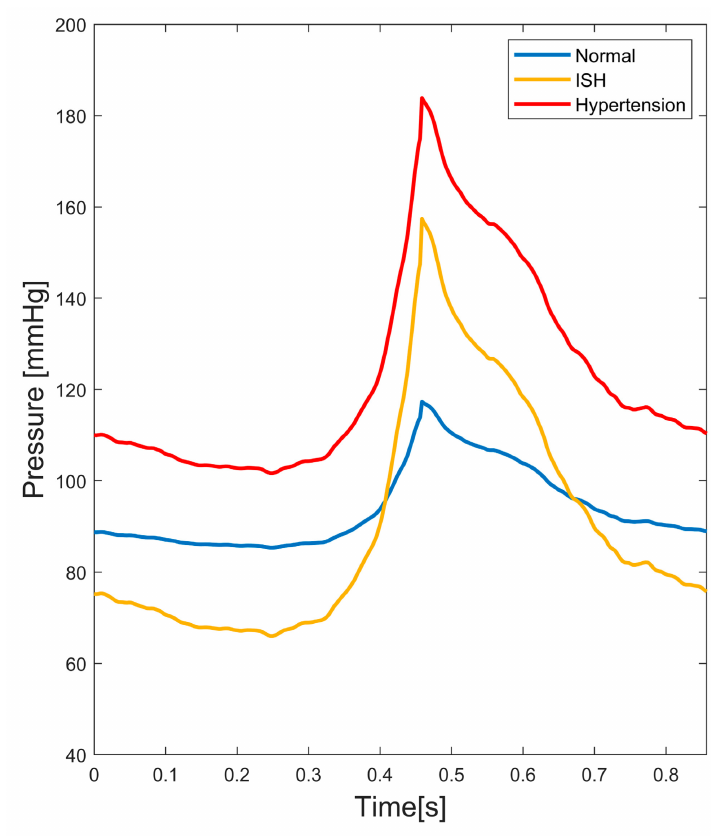
Figure 4. Pressure conditions under study: Normal (Blue), Hypertension (Red) and Isolated Systolic Hypertension (ISH) (Yellow). These are used as outlet boundary